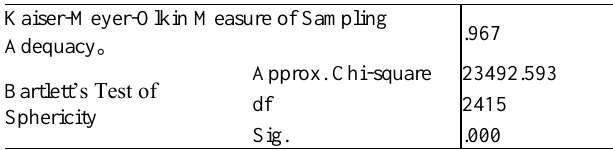
Table 2: KMO and Bartlett’s test